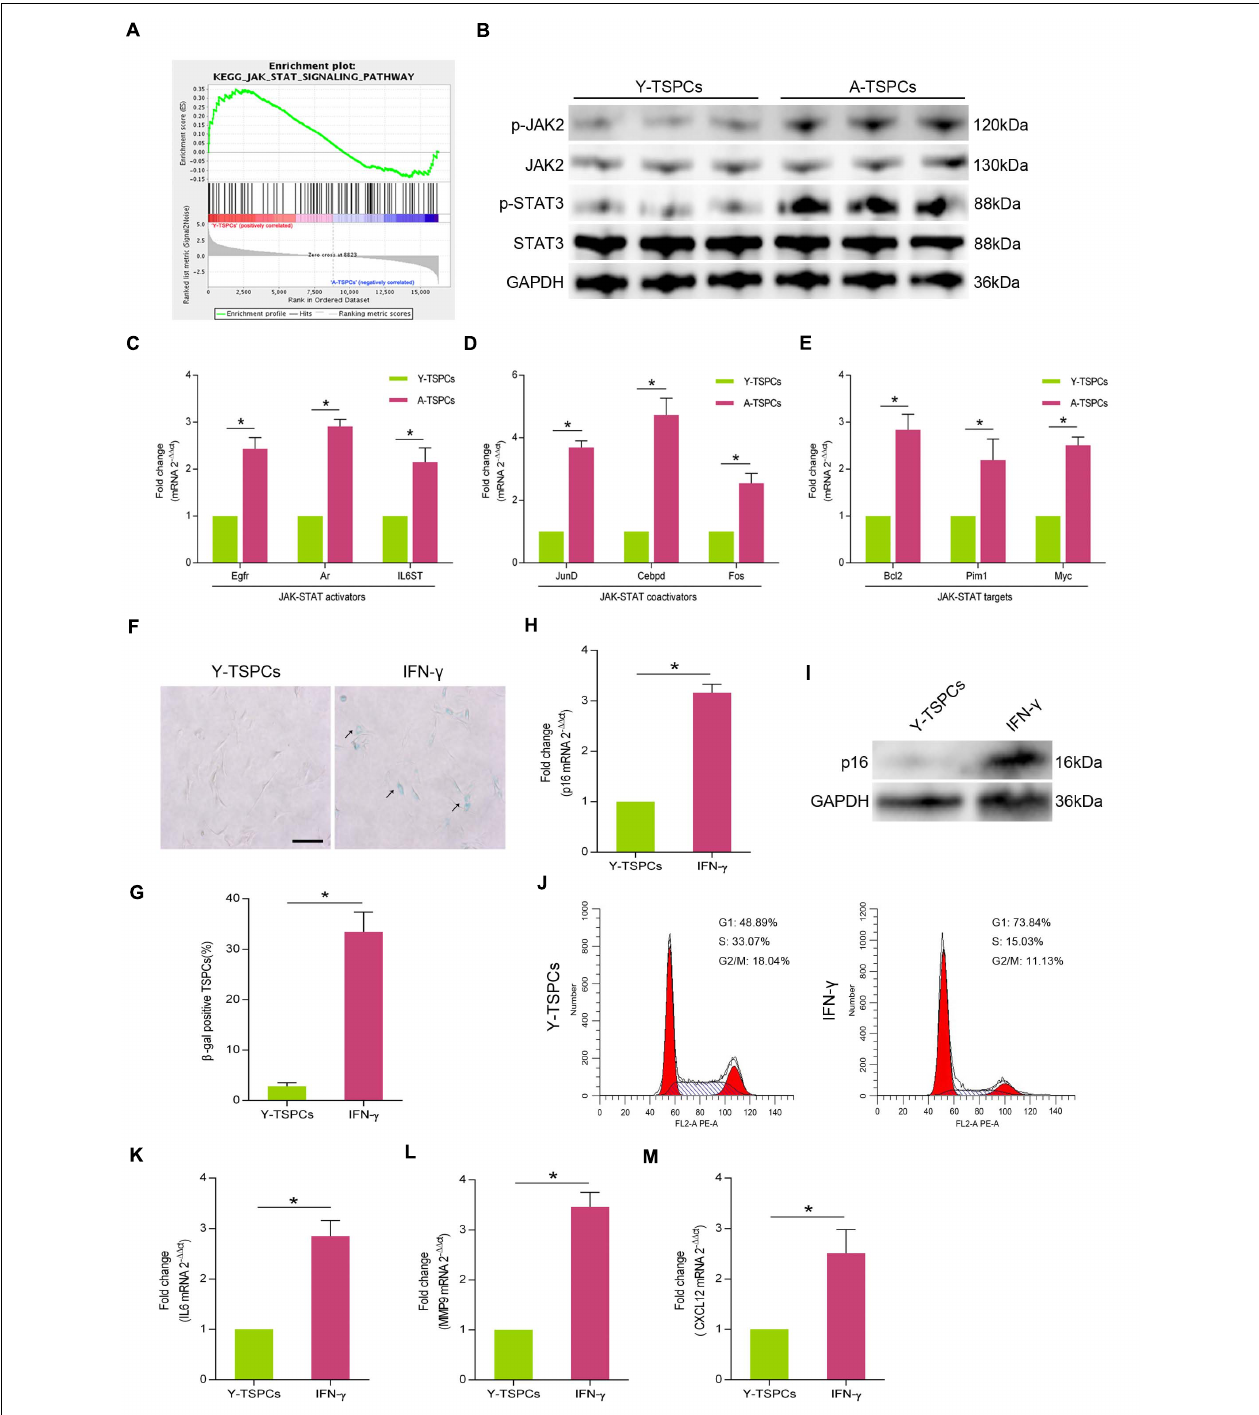
FIGURE 2 | The activity of JAK-STAT signaling pathway is increased with age. (A) GSEA plots showed a gene set related to JAK-STAT pathway. (B) Western blotting for the p-JAK2, JAK2, p-STAT3, and STAT3 protein levels in young and aged TSPCs. (C – E) Relative mRNA levels of JAK-STAT activators (Egfr, Ar, and IL6ST), JAK-STAT coactivators (JunD, Cebpd, and Fos), and JAK-STAT targets (Bcl2, Pim1, and Myc) in young and aged TSPCs were validated by qRT-PCR. (F , G) β -gal staining for the senescent cells in young TSPCs upon IFN- γ (100 ng/ml, 24 h) treatment. Scale bars: 100 µ m. (H) qRT-PCR for the p16 INK4A mRNA levels in young TSPCs upon IFN- γ treatment for 8 h. (I) Western blotting for the p16 INK4A protein levels in young TSPCs after treatment with IFN- γ (100 ng/ml, 8 h). (J) Flow cytometry analysis was used to measure the cell cycle distribution of young TSPCs after IFN- γ treatment for 48 h. (K – M) qRT-PCR for SASP genes (IL6, MMP9, and CXCL12) expressions in young TSPCs upon IFN- γ treatment for 8 h. * P < 0.05 compared with the young group.